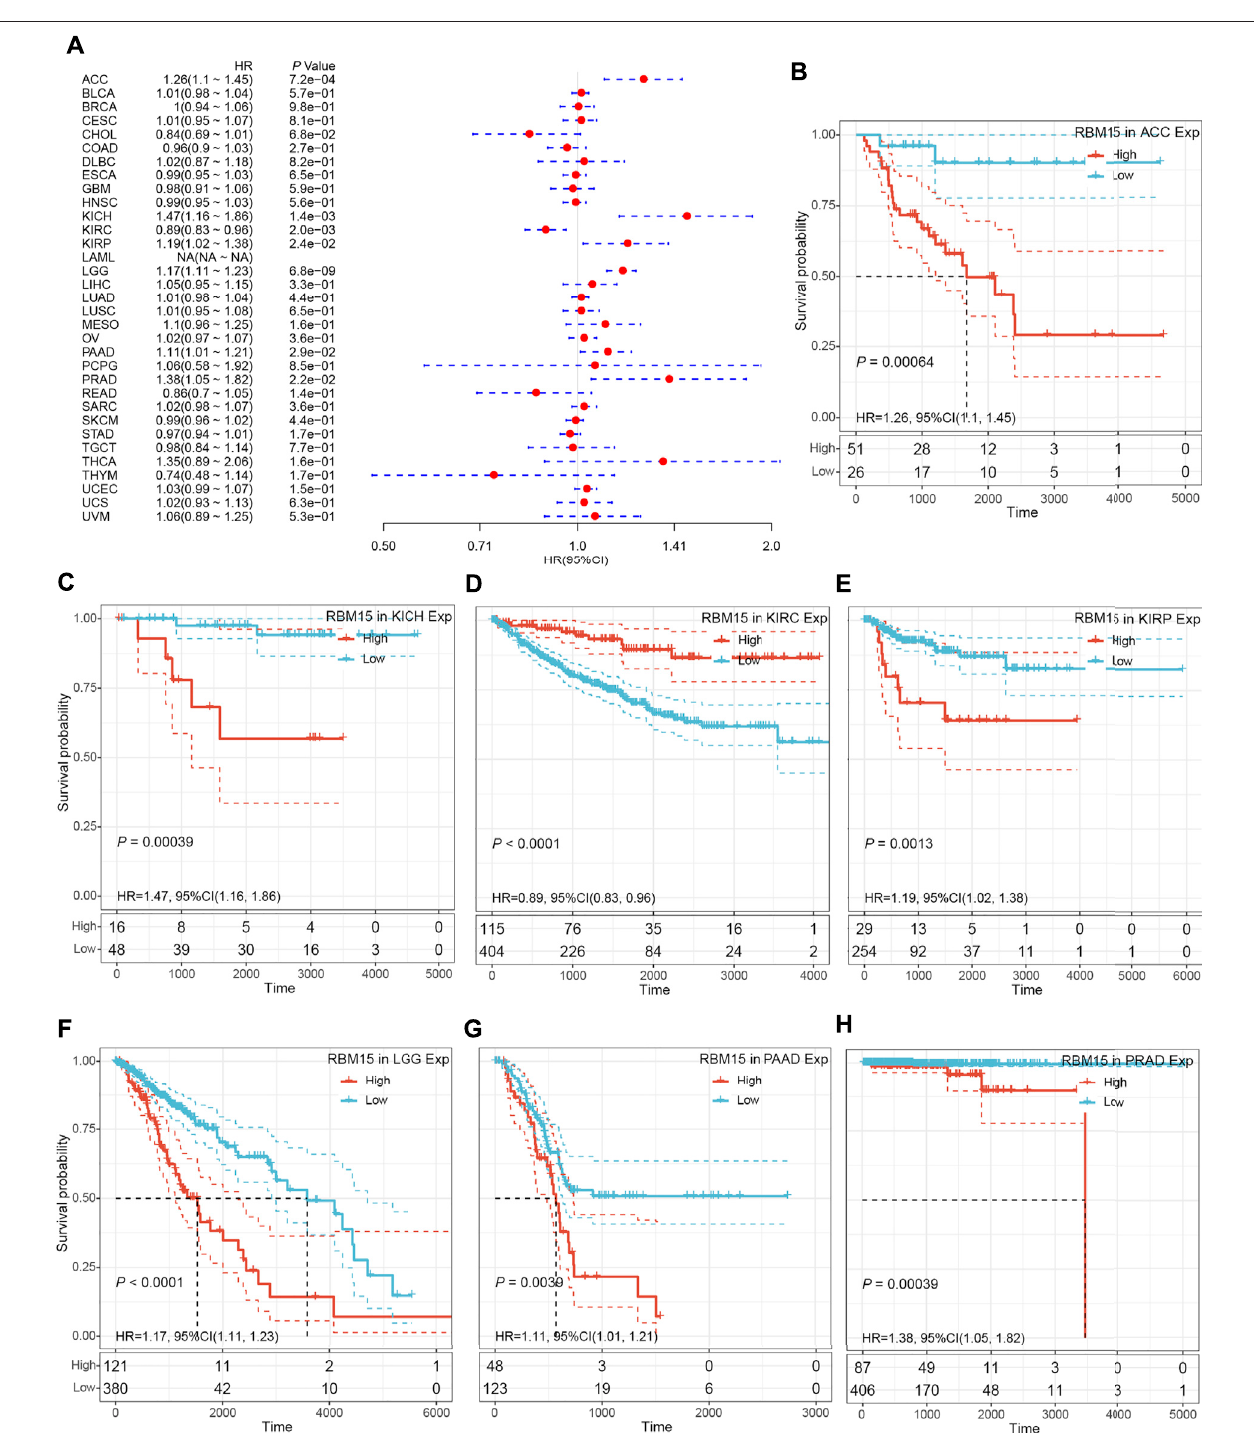
FIGURE 6 | RBM15 expression were related to patient ’ DSS. (A) Forest plots of HR for RBM15 expression in 33 tumor types. (B – H) Kaplan-Meier curves of signi fi cant correlation between RBM15 expression levels and patient ’ DSS in ACC, KICH, KIRC KIRP, LGG, PAAD and PRAD.